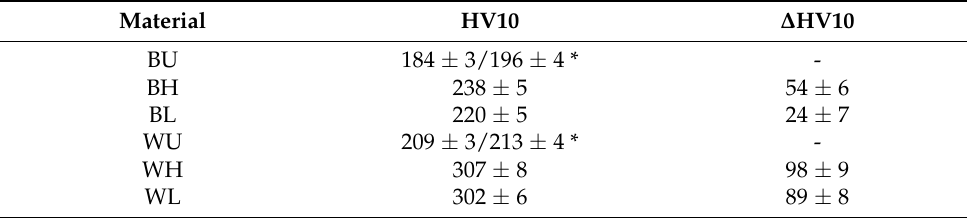
* First and second data correspond to the heats irradiated at high and low flux, respectively. All measurements indicate irradiation hardening. For the RPV base material, hard- ening appears to be larger for the high-flux irradiation. The smaller fluence (by 13%, see Table 2) received by the low-flux sample of the base material cannot explain the differ- ence. For the RPV weld, and the hardening levels for low and high flux agree within